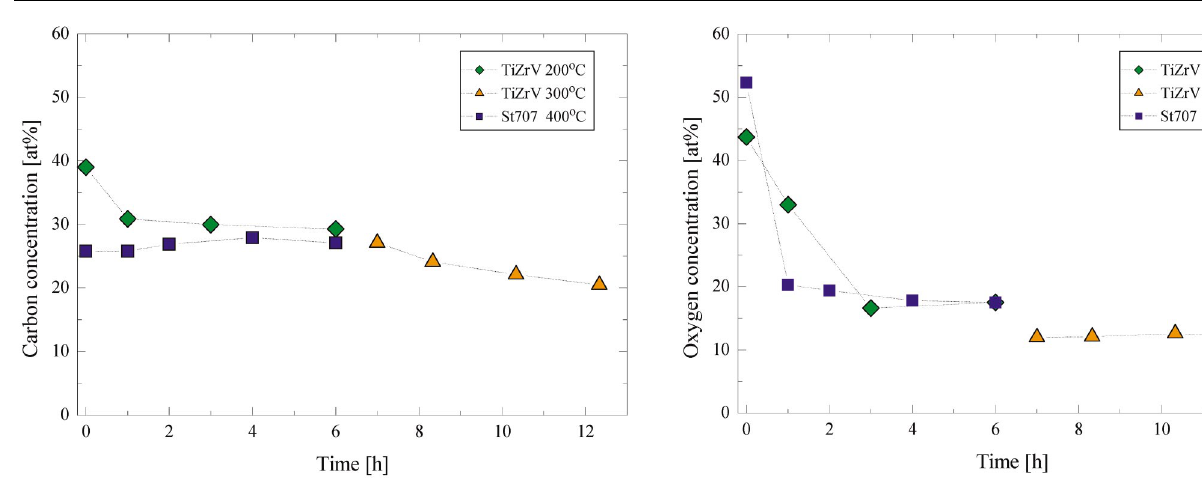
UHV.FIG. 9. (Color) Carbon surface concentration of TiZrV and St707 during a bakeout in